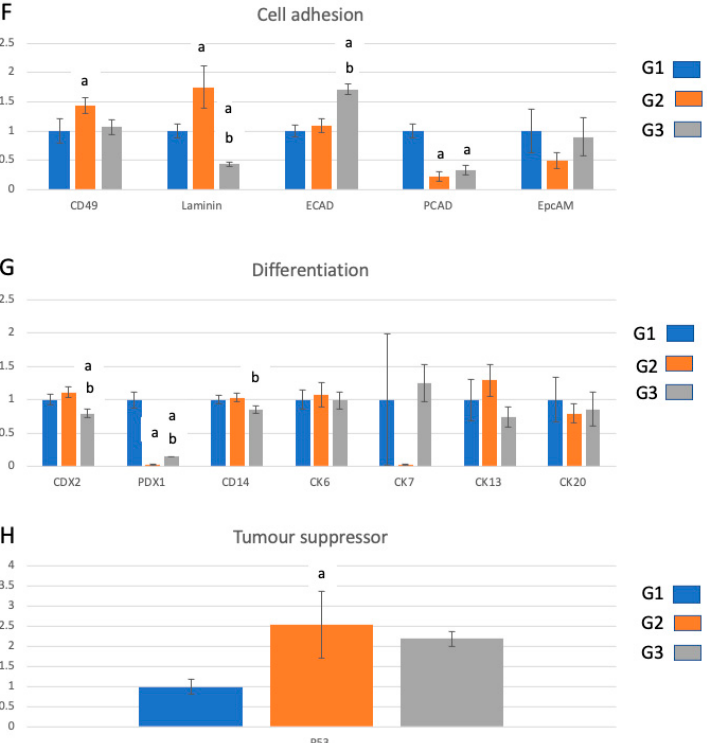
Figure 2. mRNA marker profiles in the tumour tissue across grades. The markers have been grouped according to the tumour characteristic: NE origin ( A ), proliferation ( B ), stem cell ( C ), angiogenesis ( D ), multifunctional including EMT ( E ), cell adhesion ( F ), differentiation ( G ), tumour suppressor ( H ). The marker expressions in G2 and G3 have been normalised to the average of the G1 samples. “a” represents a statistically significant difference ( p < 0.05) in marker expression in the tumour relative to that in the G1 tumour. “b” represents a statistically significant difference ( p < 0.05) in marker expression in the G3 tumour relative to that in the G2 tumour.